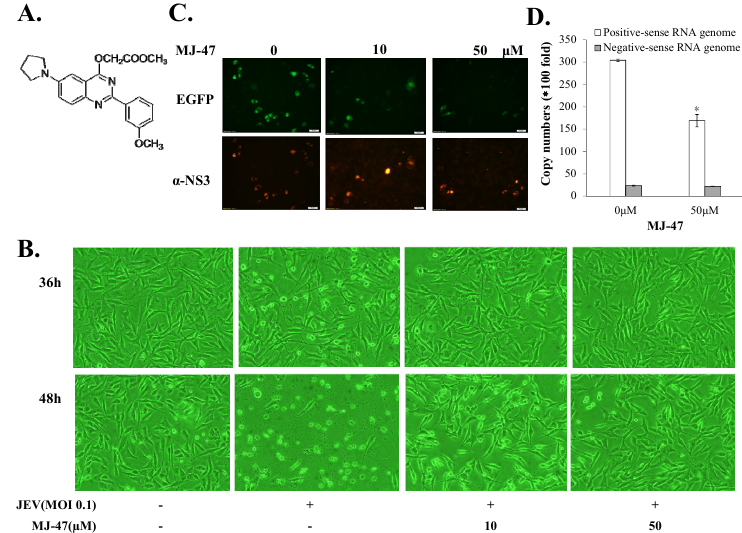
Figure 6. Reduction of JEV ‐ induced cytopathic effects and viral protein expression in the presence of MJ ‐ 47. The structure of MJ ‐ 47 (methyl 2 ‐ ((2 ‐ (3 ‐ methoxyphenyl) ‐ 6 ‐ (pyrrolidin ‐ 1 ‐ yl)quinazolin ‐ 4 ‐